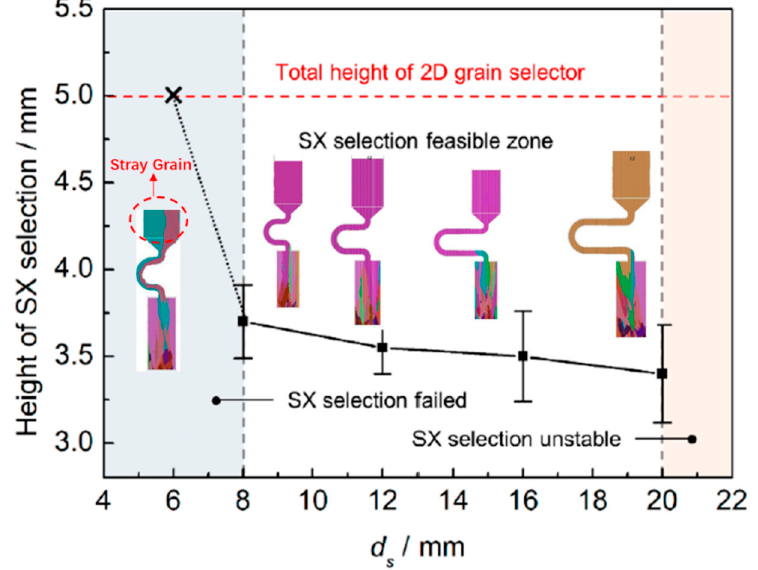
Figure 12. The simulation of different pitch length with related SX height.